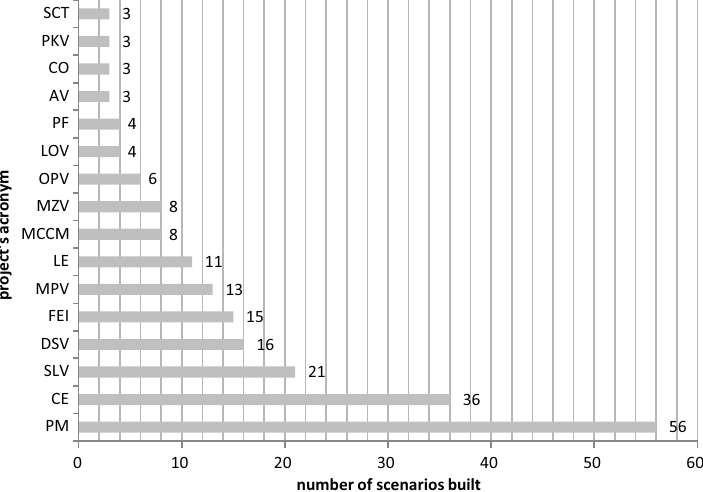
Fig. 5. The number of scenarios built in the researched Polish regional and sector foresight projects Source: own work based on questionnaire